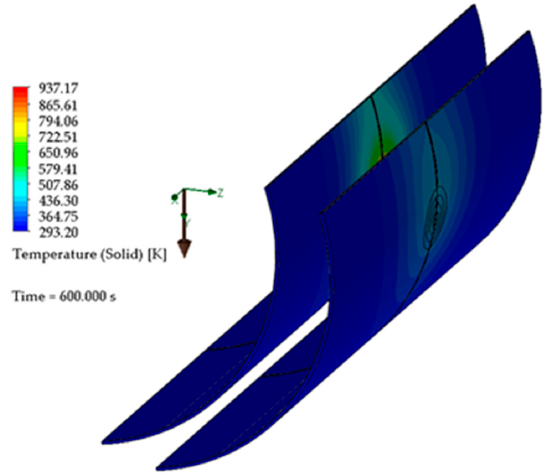
Machines 2022 , 10 , x FOR PEER REVIEW Figure 19. Temperature at 600 s. Figure 19. Temperature at 600 s.